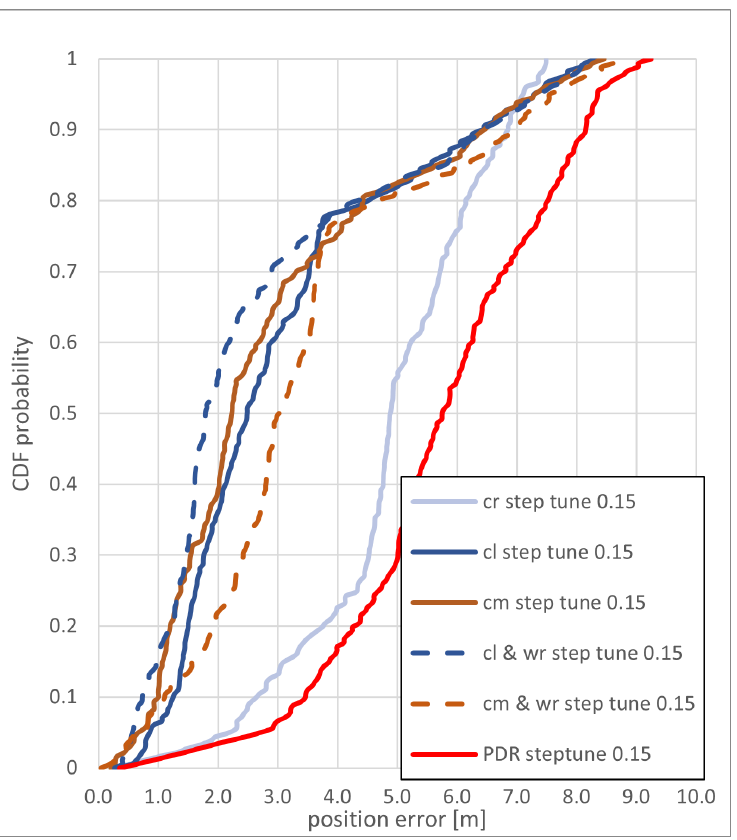
Figure 16. CDF of the positioning error of the zerotofour path with a step length correction of 0.15 m for the backtracking PF and the PDR with a step length correction of 0.15